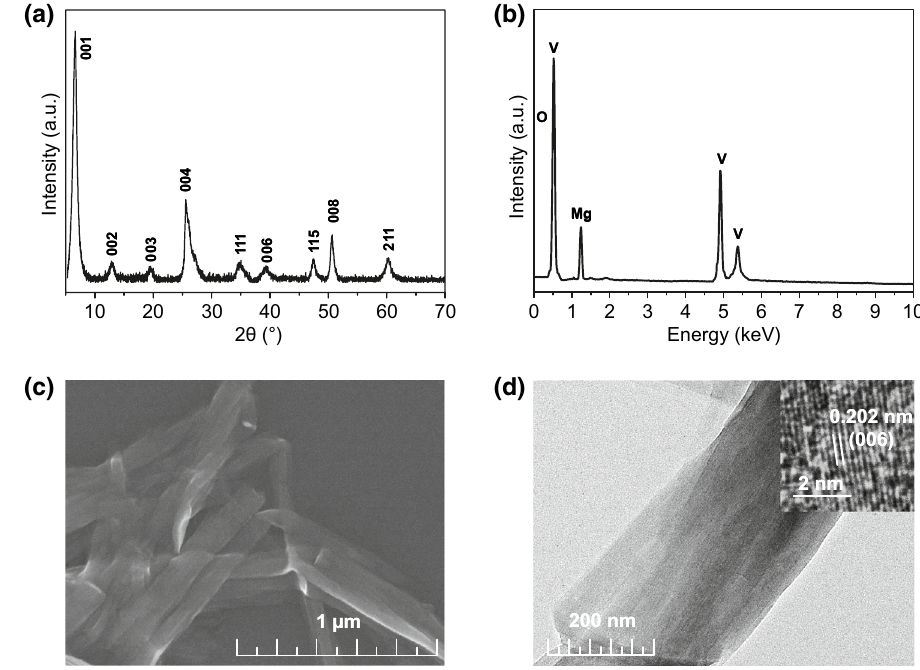
Fig. 1 Structural characterization of MgVO cathodes: a XRD pattern, b EDS spectrum, c SEM image, d TEM